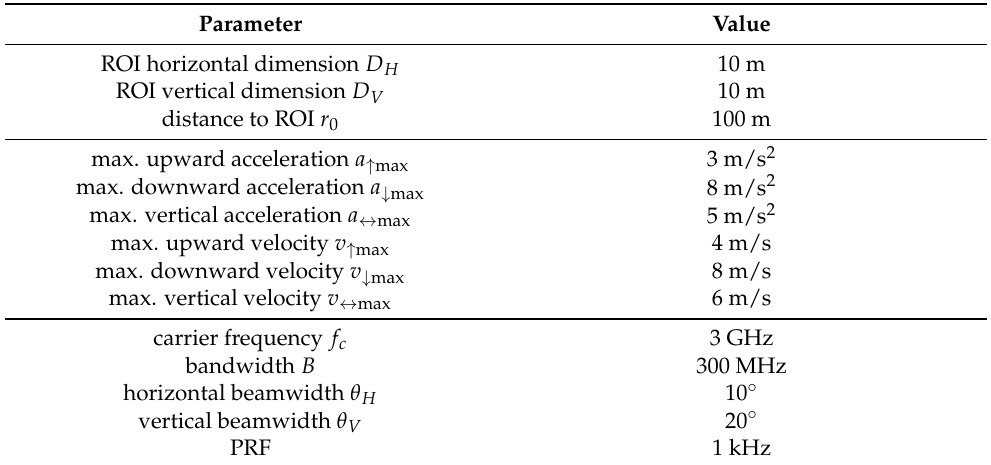
Table 1. Test scenario and radar